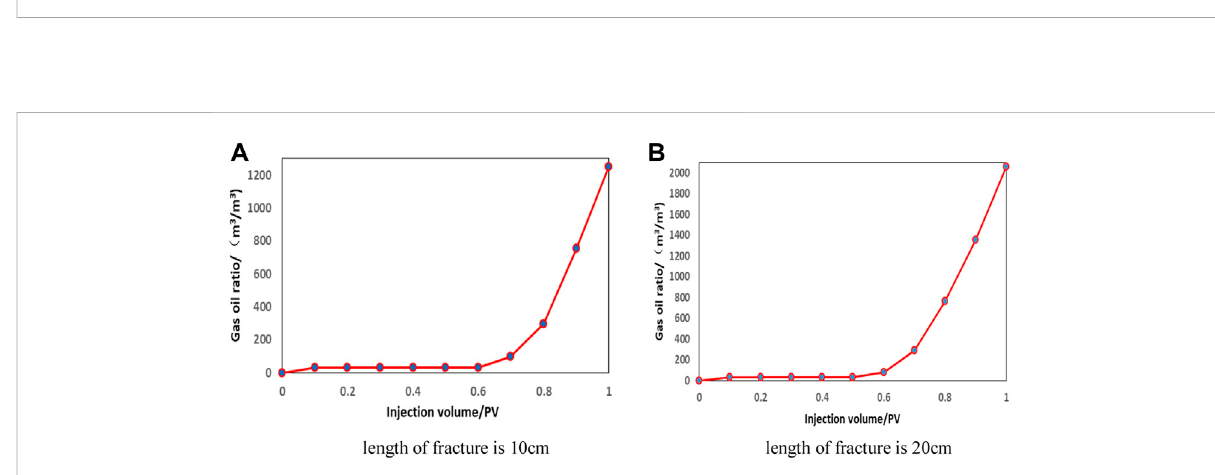
FIGURE 4 Pressure distribution in cores with different fracture lengths. (A) Length of fracture 10 cm and (B) length of fracture 20 cm.